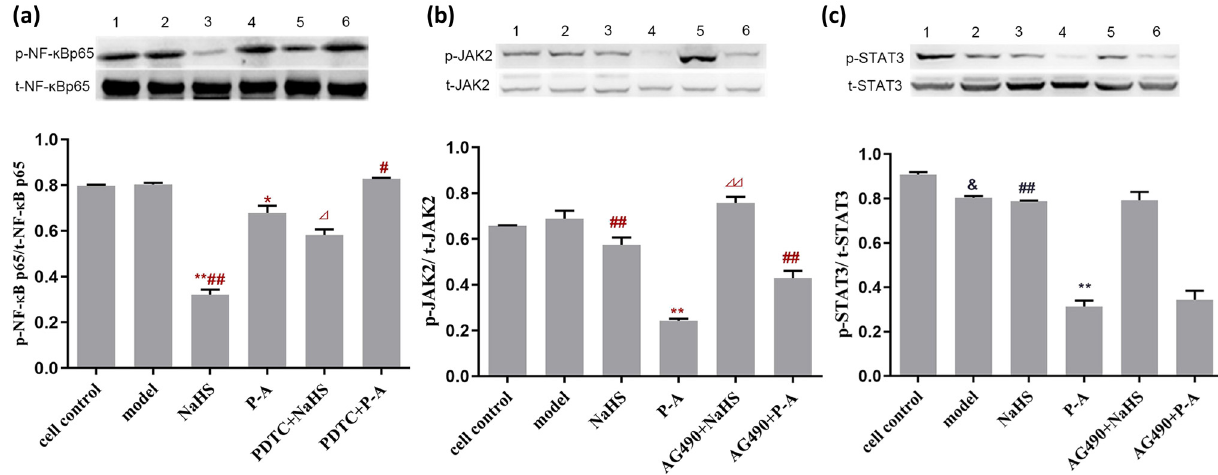
Figure 5: P - A regulates expression of IL - 6, IL - 10, and TNF - α through NF - к B and JAK/SATA pathways. ( a ) The expression of p - NF - к B p65 protein in HUVEC damage model. ( 1 ) cell control; ( 2 ) model; ( 3 ) NaHS; ( 4 ) P - A; ( 5 ) PDTC + NaHS; ( 6 ) PDTC + P - A. * P < 0.05 ** P < 0.01 vs model; # P < 0.05 ## P < 0.01 vs P - A; ⊿ P < 0.05 vs NaHS. Mean ± SD, n = 3. ( b ) The expression of p - JAK2 protein in the HUVEC damage model. ( 1 ) cell control; ( 2 ) model; ( 3 ) NaHS; ( 4 ) P - A; ( 5 ) AG490 + NaHS; 6: AG490 + P - A. ( c ) The expression of p - STAT3 protein in the HUVEC damage model. ( 1 ) cell control; ( 2 ) model; ( 3 ) NaHS; ( 4 ) P - A; ( 5 ) AG490 + NaHS; 6: AG490 + P - A. ** P < 0.01 vs model; ## P < 0.01 vs P - A; ⊿⊿ P < 0.01 vs NaHS. Mean ± SD, n = 3.